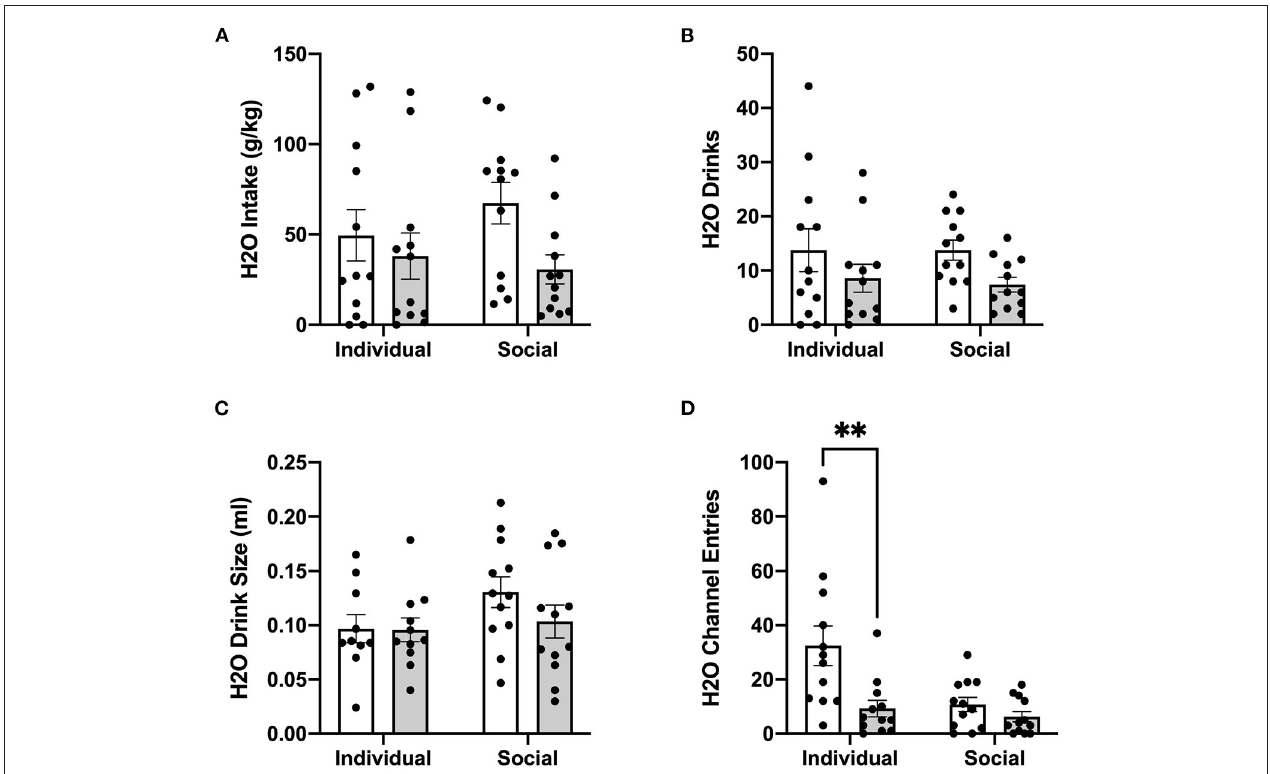
FIGURE 8 | 24 h cumulative water data post-CRFR1 antagonism. (A) Water intake in g/kg. (B) Number of water drinks. (C) Water drink size in mls. (D) Water channel entries. ** p < 0.01, compared to CP-376,39- treated individually-housed mice. While water drink size was unaffected by CRFR1 antagonism, this treatment caused significant decreases in g/kg water intake and number of water drinks across both housing conditions. As observed with the ethanol channel, this treatment also caused a selective decrease in non-consummatory channel entries in individually-housed mice. Data represented as mean ± SEM. n =